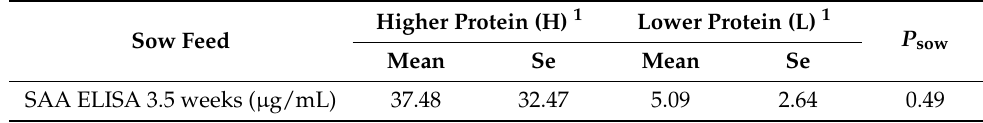
Table 3. Mean values for the SAA ELISA serum concentrations at 3.5 weeks of age of the piglets with only a sow late gestation treatment at weaning.